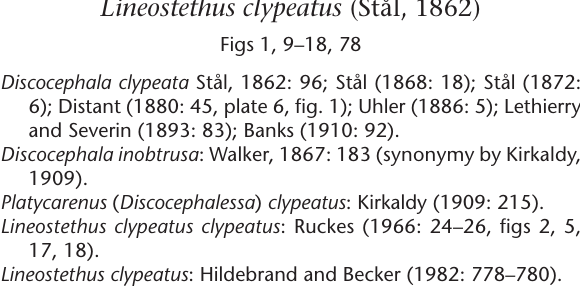
angles (Fig. 9: fdr, pa); posterior limit of ventral rim subrectilinear (Fig. 10) ...... L. clypeatus (Stål, 1862) (Fig. 1) 5’ Foliaceous expansions of dorsal rim at least as long as both the posterior limit of ventral rim and the posterolateral angles, hiding or not the posterolateral angles in dorsal view (Figs 19, 27, 45: fdr, pa); posterior limit of ventral rim sinuous (Figs 20, 28, 46) ........................................... 6 6(5’) Foliaceous expansions of dorsal rim subquadrangular and expanded, hiding the posterolateral angles dorsally; cutting of dorsal rim subrectangular around the segment X (Fig. 19: fdr, pa, dr); margin of inferior layer of ventral rim with two lines of short bristles (Fig. 20: b) .................. Foliaceous expansions of dorsal rim subrectangular and not expanded, leaving the posterolateral angles visible dorsally; cutting of dorsal rim U-shaped around the segment X (Figs 27, 45: fdr, pa, dr); margin of inferior layer of ventral rim with one line of short bristles (Figs 7(6’) Foliaceous expansions of dorsal rim longer than both the posterior limit of ventral rim and the posterolateral angles (Fig. 45: fdr); apex of the projections of the superior layer of ventral rim spatulate (Fig. 47: psl) ................................. ... L. sinuosus Kochenborger & Garbelotto sp. nov. (Fig. 5) Foliaceous expansions of dorsal rim at maximum as long as both the posterior limit of ventral rim and the posterolateral angles (Fig. 27: fdr); apex of the projections of the superior layer of ventral rim acute (Fig. 28: psl)